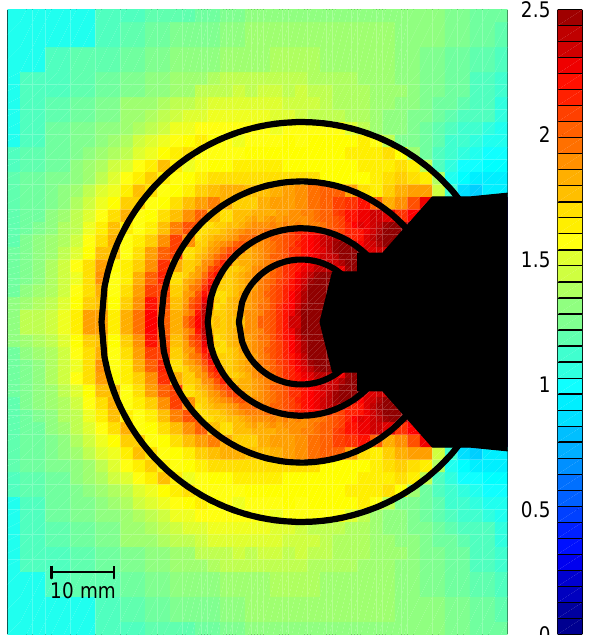
Fig. 4. Simulated density field inside the CONE ionization gauge. Densities are given in units relative to the undisturbed density of the background flowfield.